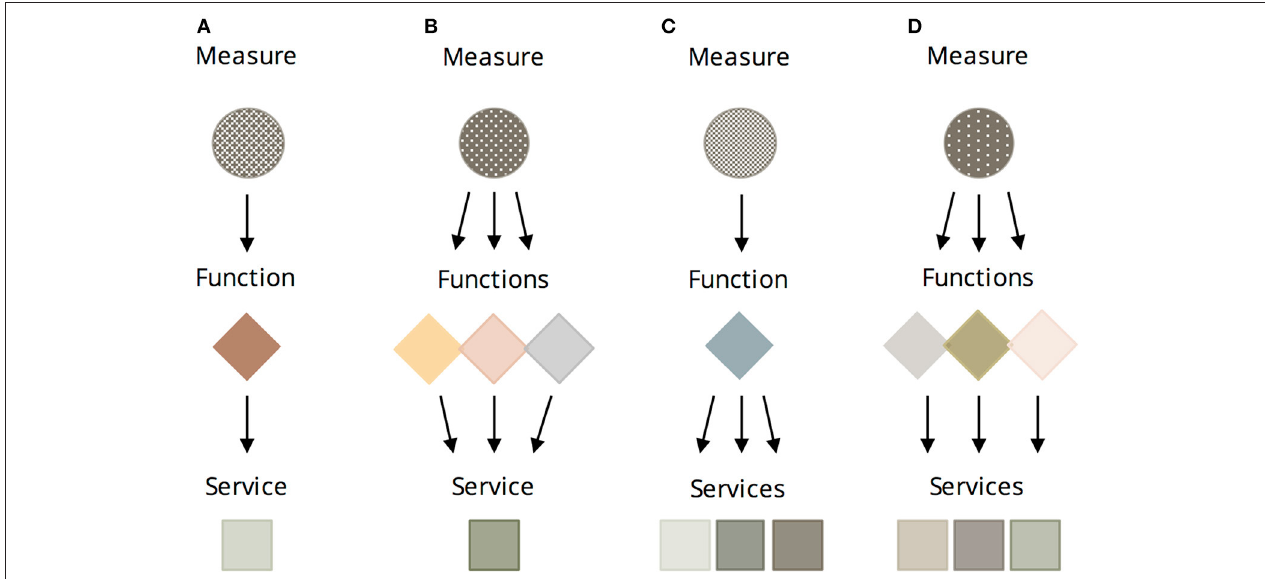
FIGURE 1 | A conceptual representation of a cascade based understanding of how agri-environmental measures can enhance one or several ecosystem services. These services come as a result of benefitting organisms performing one (A,C) or several (B,D) relevant ecosystem functions. The figure illustrates that multifunctional landscapes can be achieved either through benefitting several functions (B) or through a single function with benefits multiple final services (D)